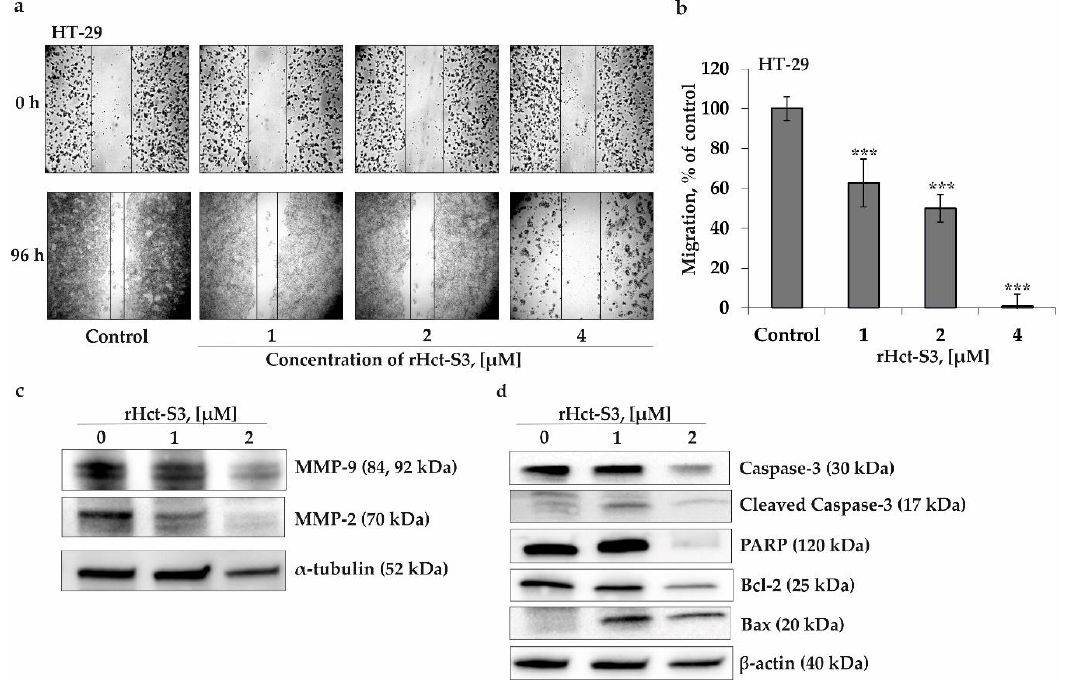
Figure 4. Effects of rHct-S3 on migration of HT-29 cells, MMPs and apoptotic proteins. ( a , b ) The HT-29 cells migration distance was measured the width of the wound and expressed as a percentage of each control for the mean of wound closure area. All experiments were repeated at least three times in each group (n = 18 for control and each compound, n—quantity of photos). The magnification of representative photos is ×10. The asterisks (*** p < 0.001) indicate a significant decrease in migration of cells treated with rHct-S3 compared with the non-treated cells (control) ( c , d ) rHct-S3 inhibited MMP-9, MMP-2 expression and regulated caspase-3, cleaved caspase-3, PARP, Bcl-2 and Bax in HT-29 cells, as determined by Western Blotting with specific